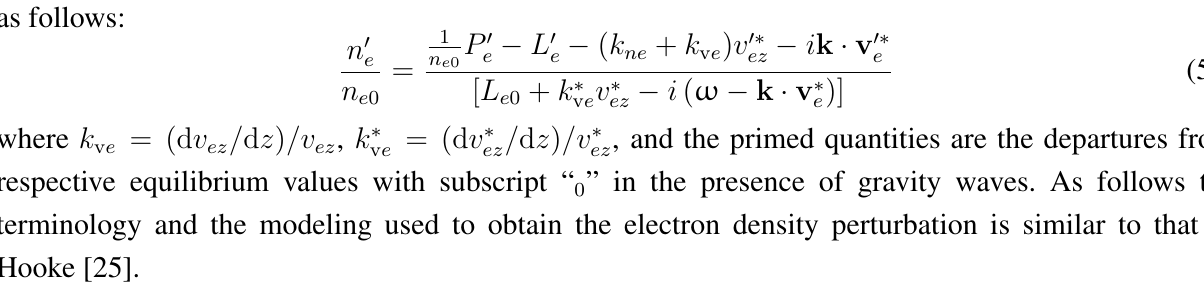
Figure 5. LHS: Vertical profile of F-dynamo electric field E E = 0 (from Equation (46)); RHS: Vertical profile of atmospheric wind perturbation z damping factor, α , used in n (cid:48) and total electron content (TEC) calculations (from Figure 5a d e of